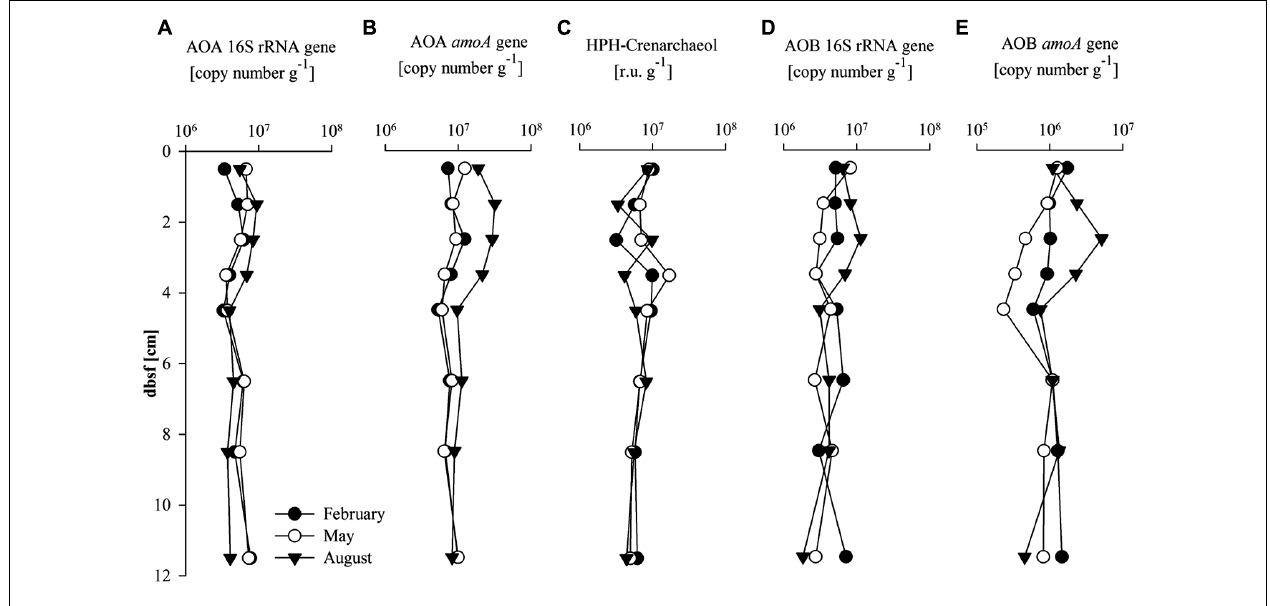
FIGURE 2 |Abundance of (A) ammonia oxidizing Archaea (AOA) 16S rRNA gene (copy number g –1 ); (B) AOA amo A gene (copy number g –1 ); (C) Hexose phosphohexose (HPH)-crenarchaeol (response